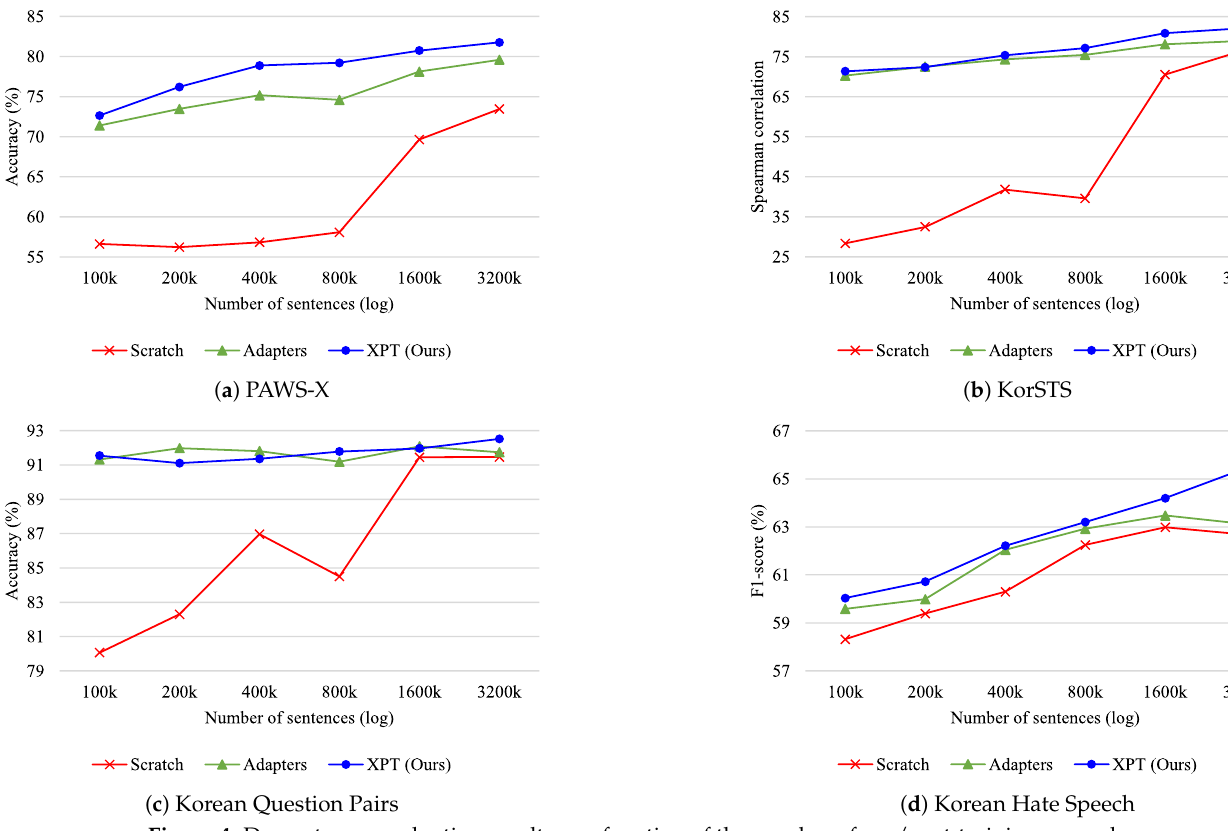
Figure 4. Downstream evaluation results as a function of the number of pre/post-training